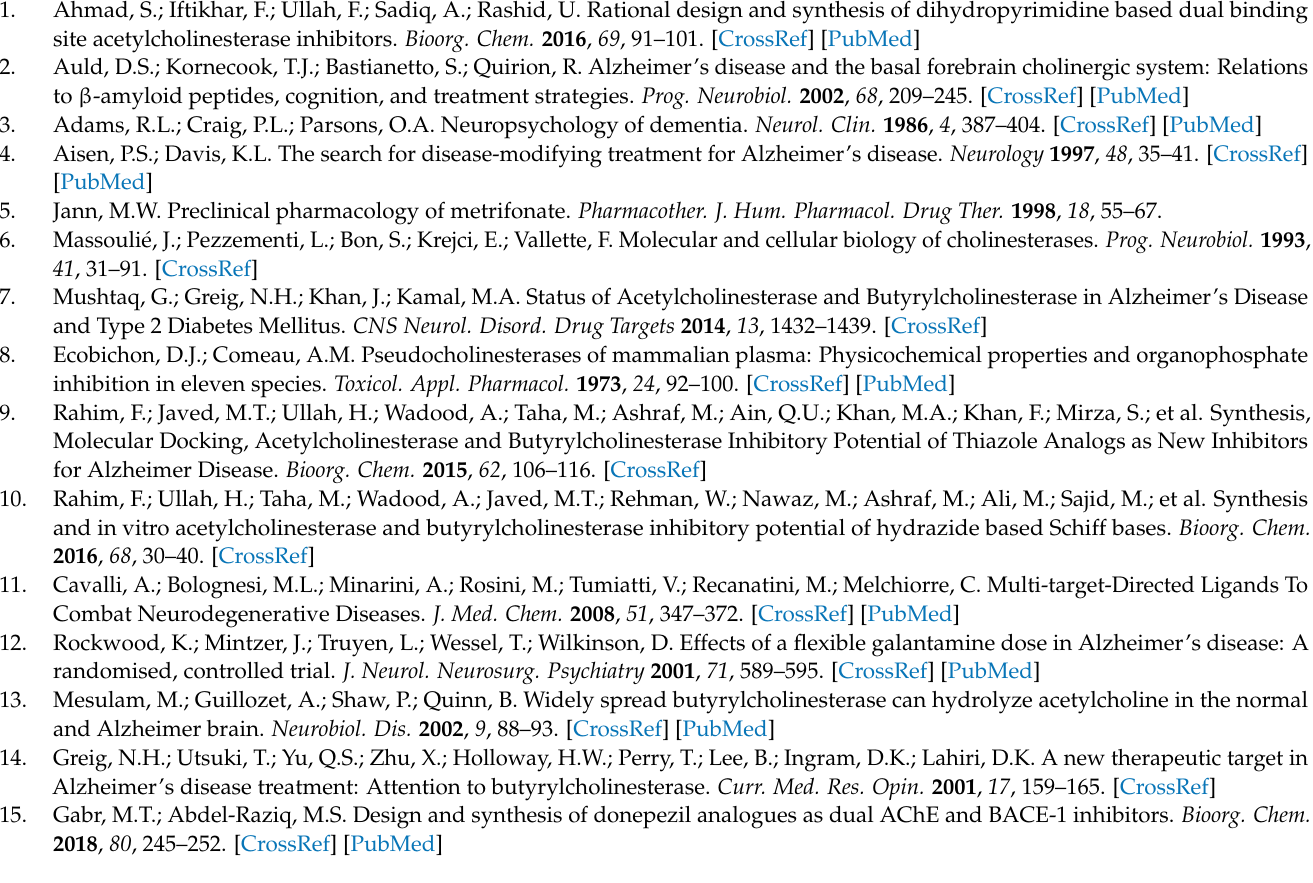
Figure S2: Molecular Electrostatics Potential (MESP) of representative thiazole bearing sulfonamide analogues ( 3–21 ); Figure S3: HOMO-LUMO orbital densities of studies thiazole bearing